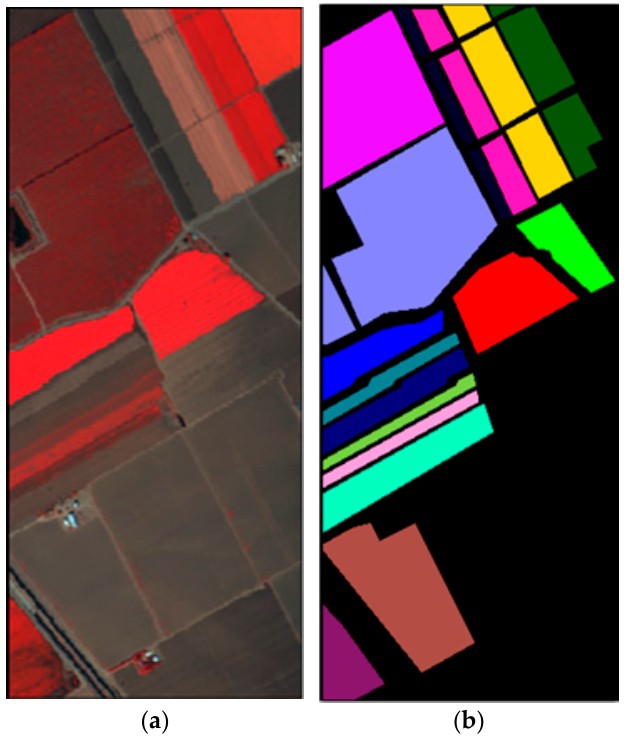
Figure 3. Dataset Salinas: ( a ) False color image; ( b ) Class label map.